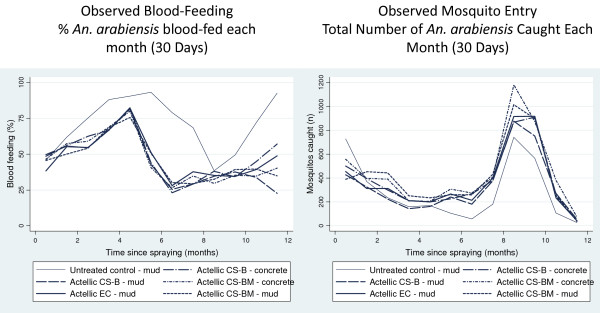
Percentage blood-fed Anopheles arabiensis collected in experimental huts over time by treatment (left) and number of Anopheles arabiensis caught per treatment over time (right). Data on wild mosquitoes recorded on a daily basis were variable. Graphs of blood feeding and number of mosquitoes caught over time plot data pooled for each month since spraying.